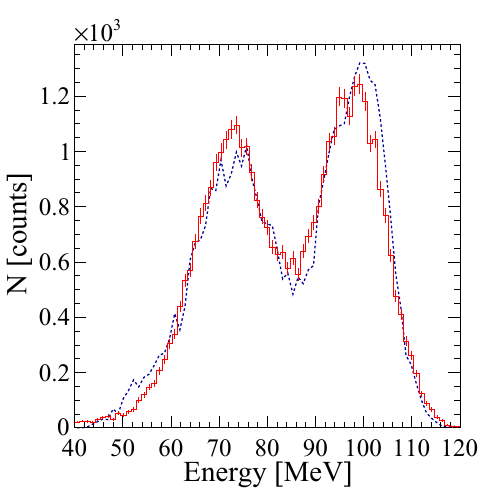
Figure 4. Distributions of kinetic energy of fragments issued from spontaneous fission of a 252 Cf source, reconstructed be- tween the two ToF detectors. The red line is the data measured with the FALSTAFF setup while the blue line is the result of a GEANT4 simulation of the setup using